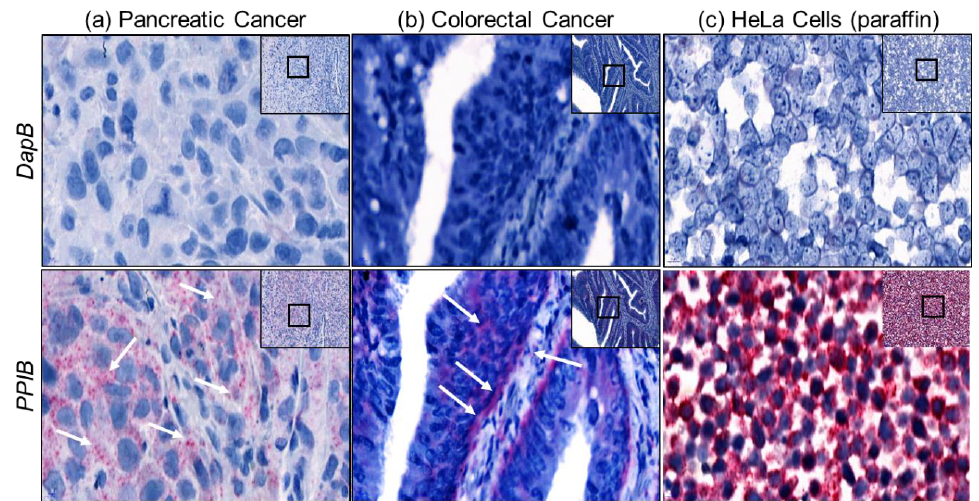
Figure 2. Validation and optimization of the Z-probe staining. Paraffin embedded, and sectioned, pancreatic cancer tissue, colorectal cancer tissue and HeLa cell pellet were stained with a negative control probe DapB (full form) and a positive control probe PPIB (full form). The PPIB stained well with pancreatic, colorectal and HeLa cells (bottom panel ( a – c ). 20× (inset) and 80× magnification using CaseViewer 2.2 software (3DHistech Ltd., Budapest, Hungary) scanned and analyzed on Pannoramic 250 Flash III (3DHistech Ltd.). Arrows point at specific staining.